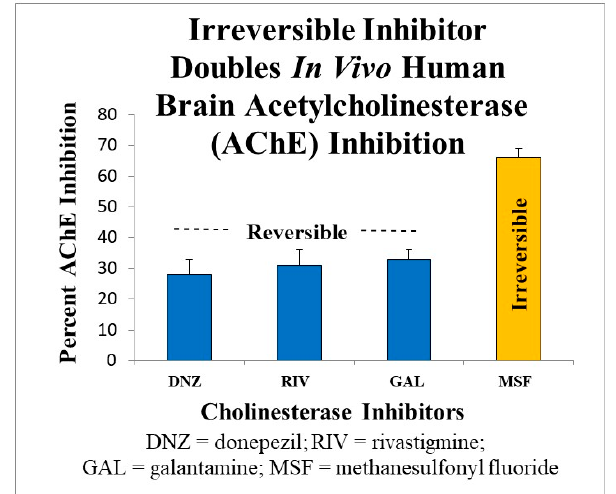
Figure 4. Comparison of brain AChE inhibition produced by reversible inhibitors (donepezil, rivastigmine, and galantamine) to an irreversible inhibitior (methanesulfonyl fluoride). The reversible AChE inhibitors, because of peripheral toxicity, cannot be tolerated by patients at doses that produce more than about 25%–35% AChE inhibition in the brain [82–86]. In contrast, an irreversible AChE inhibitor, because of inherent selectivity for inhibiting brain AChE and the absence of peripheral toxicity, can be administered at doses that produce ~66% brain AChE inhibition [69,126], a level that is within the therapeutic window [87–89] and is associated with strong cognitive improvement [126].